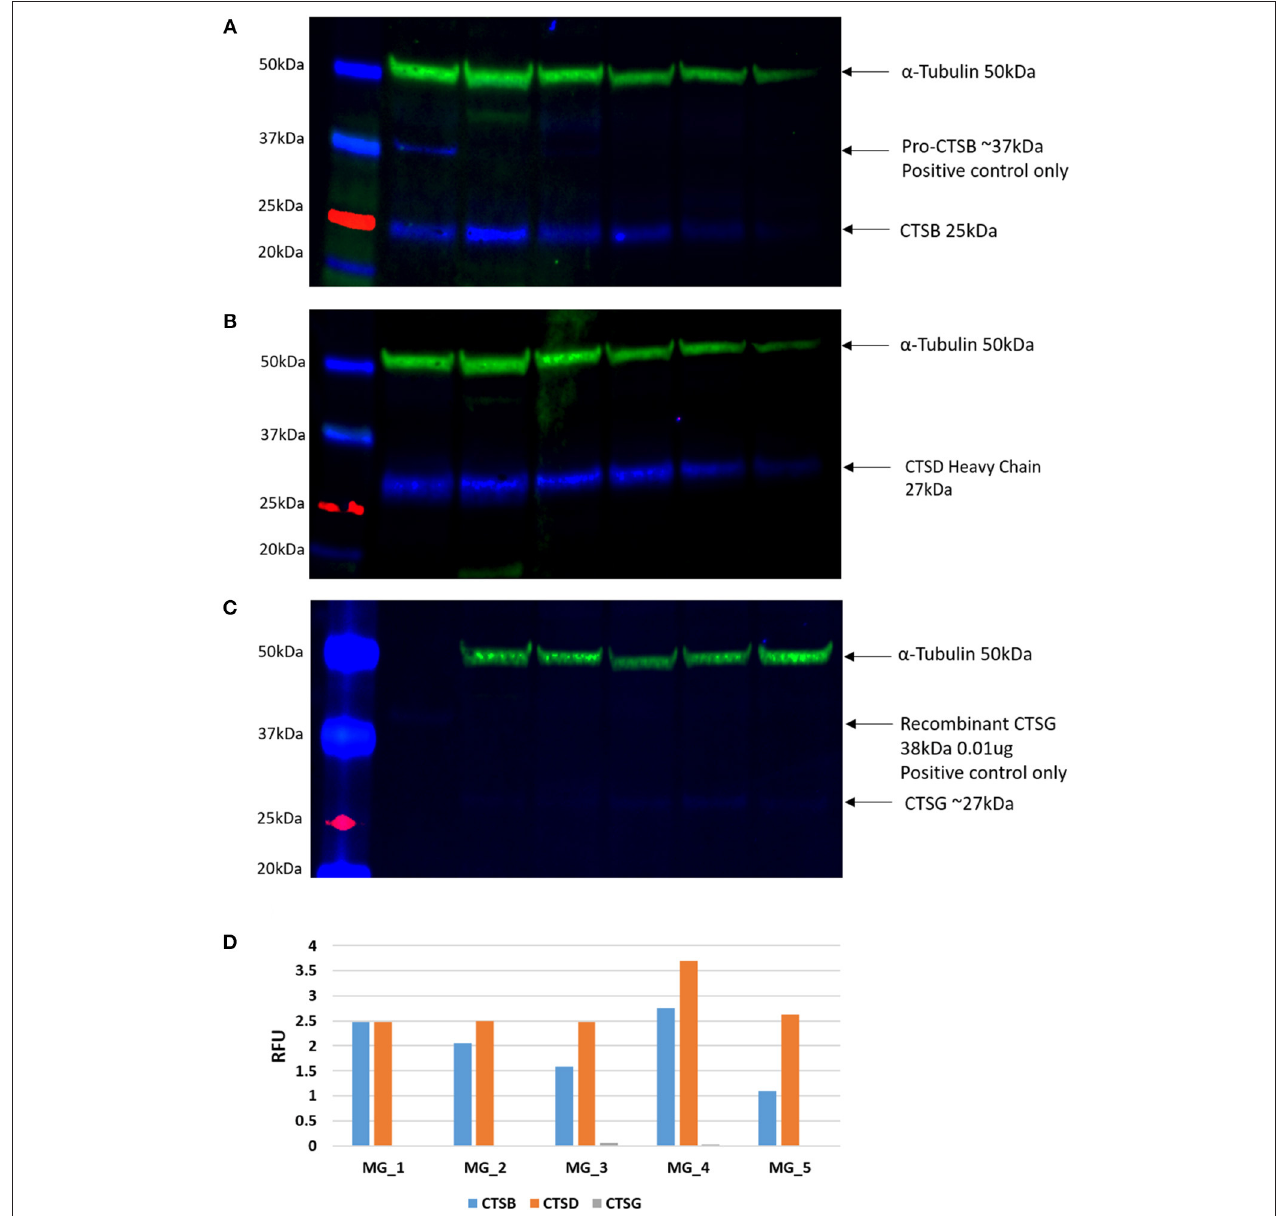
FIGURE 4 | Individual Western blotting results for cathepsin B (CTSB) (A) , cathespsin D (CTSD) (B) and (C) in six WHO grade I meningioma (MG) samples. The approximate protein loading equivalent for all MG samples was confirmed with α -tubulin (A–C) . Densitometry results demonstrated the average intensity of each blot, by cathepsin, expressed in relative fluorescence units (RFU; D